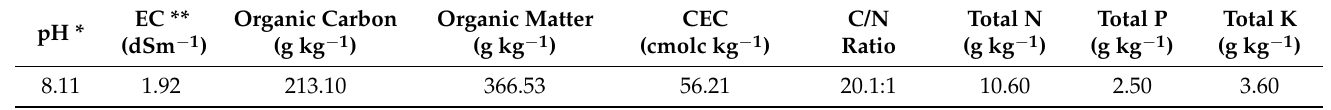
Table 3. Some chemical properties of